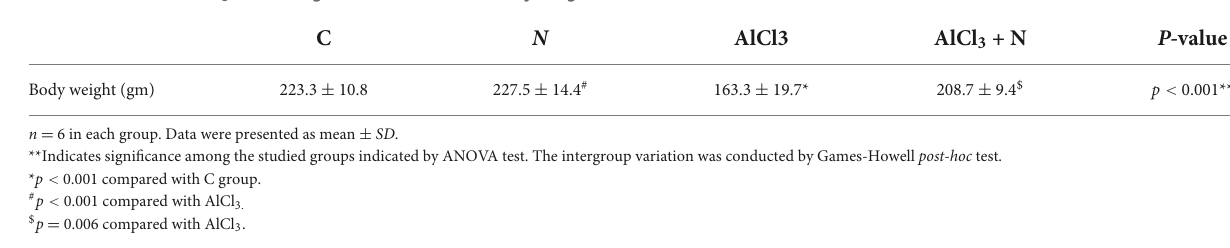
TABLE 1 Effects of AlCl 3 and naringin administration on body